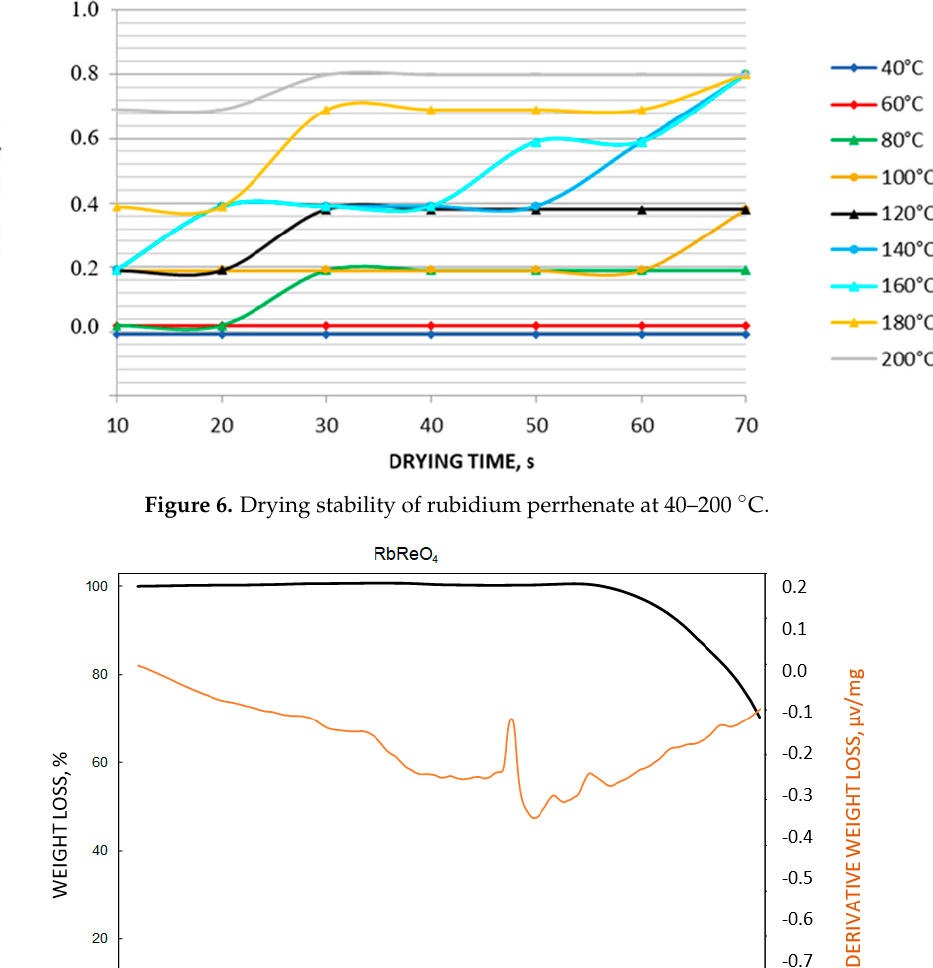
Figure 7. Drying stability of rubidium perrhenate at 30–1000°C.